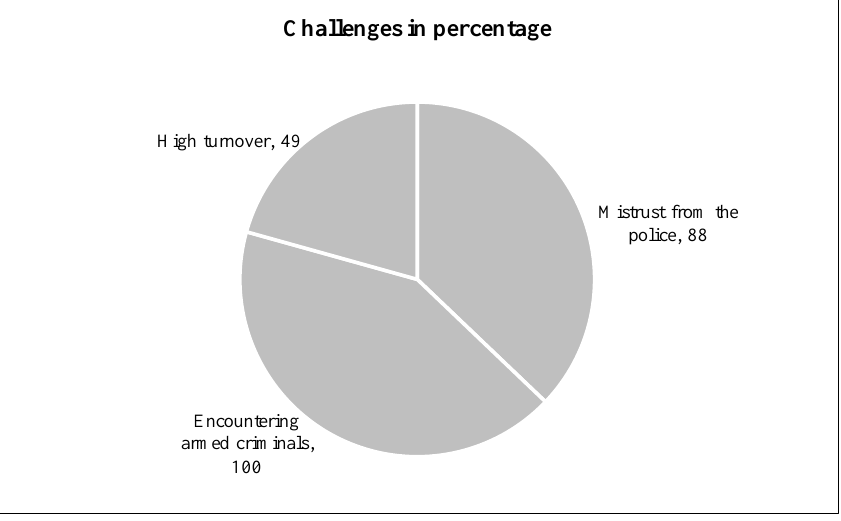
Figure 4. Commercial Security Providers